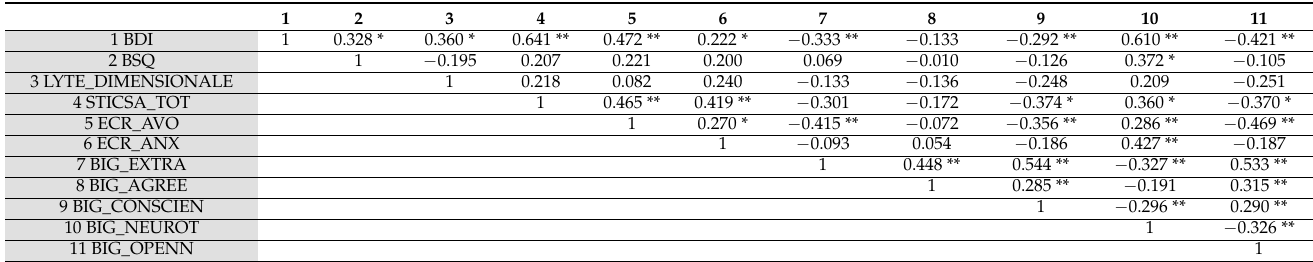
Table 3. Correlations of the key variables in the PRE-group.